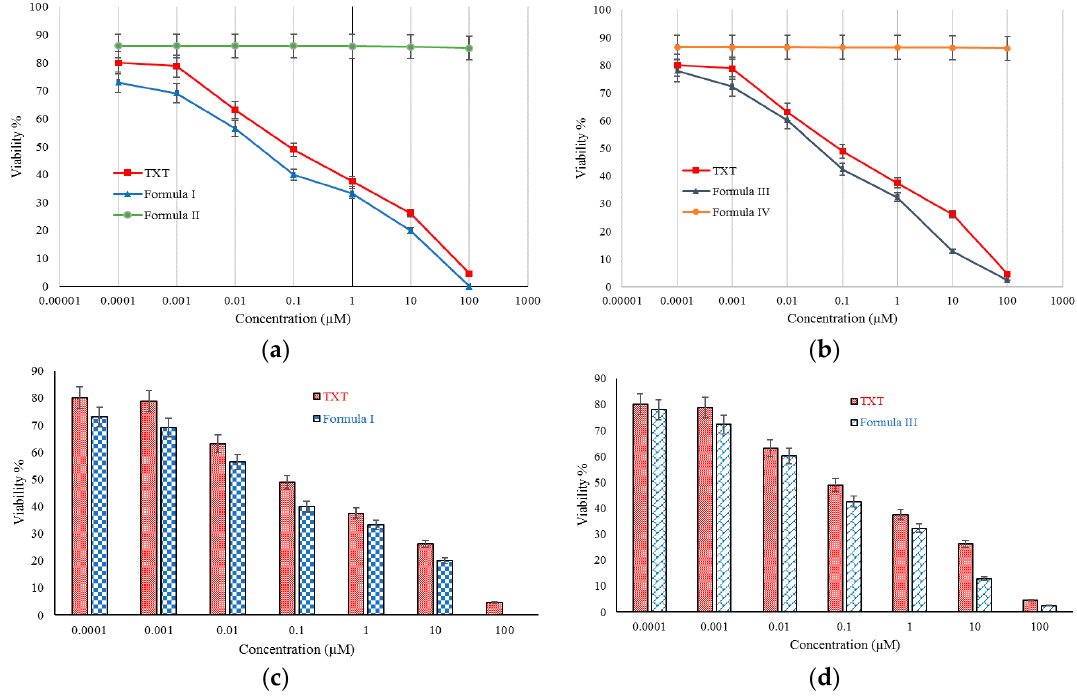
Figure 5. Cytotoxicity of TXT and formulation I to IV on C26 cell lines after 72 h exposure to 0.0001~100 M samples by MTT assay. ( a ) viability of C26 cell lines for formulation I, II, and TXT; ( b ) viability of C26 cell lines for formulation III, IV, and TXT; ( c ) viability percentages of C26 cell lines for formulation I and TXT; ( d ) viability percentages of C26 cell lines for formulation III and TXT.